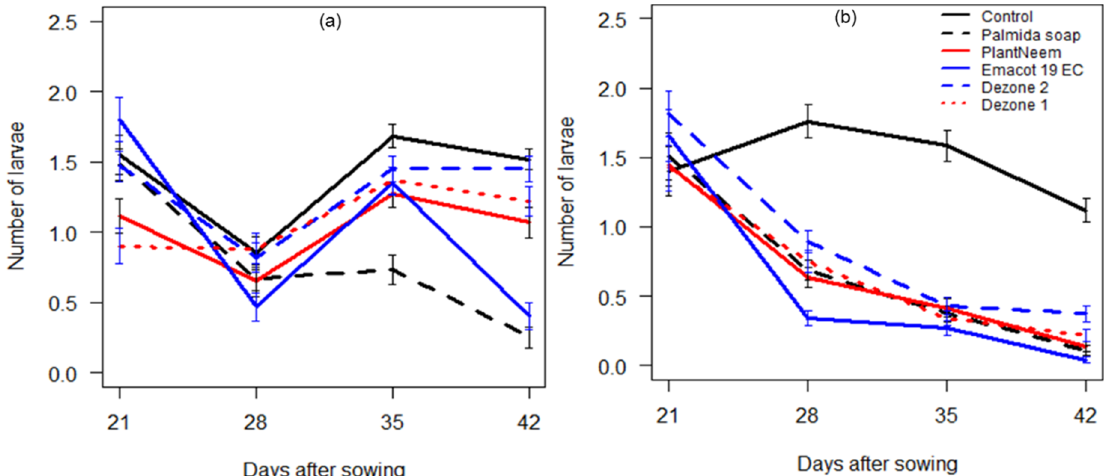
Figure 1. Mean numbers (±SE) of Spodoptera frugiperda larvae per plant based on weekly observations of 15 maize plants per plot at Adjohoun ( a ) and 30 plants at N’Dali ( b ) on each collection date. The treatments included Palmida soap, PlantNeem, Emacot 19 EC, Dezone, and the untreated control. Dezone 1 and 2 refer to application rates of 7.5 and 15 kg/ha, respectively.